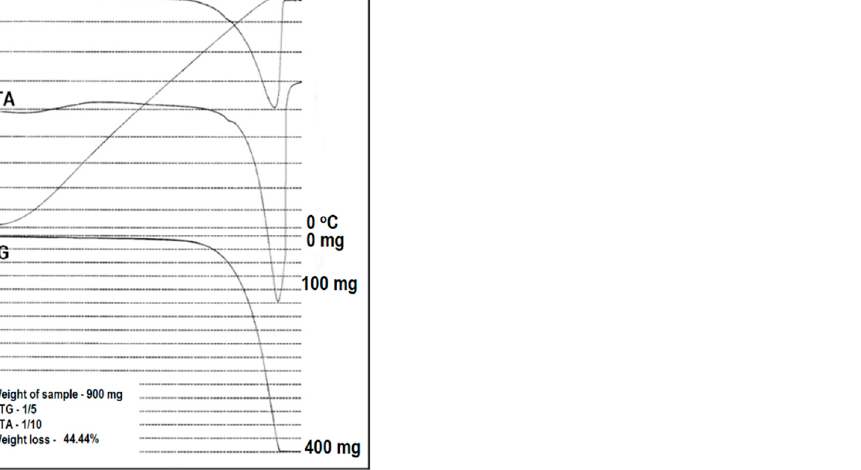
Figure 7. Derivatogram of sample S8, limestone of the Dziewkowice Unit taken in the Szymiszów Quarry [21].